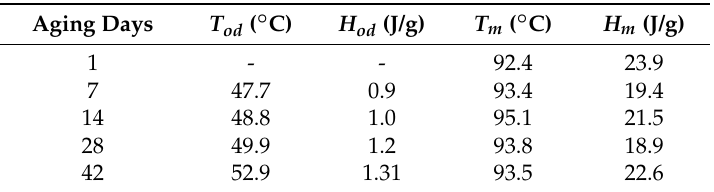
Figure 4. DSC curves of the EMAA ionomer at different aging times (curves are vertically shifted for better readability). Table 1. Thermal properties estimated by DSC after different aging times. Indices od and m refer to the order-disorder transition and to the melting respectively.